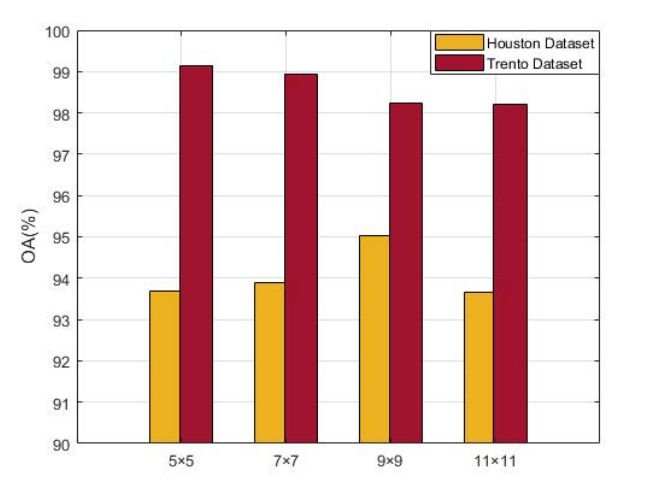
Figure 6. Classification performance of the proposed PC 2 ANet with different patch